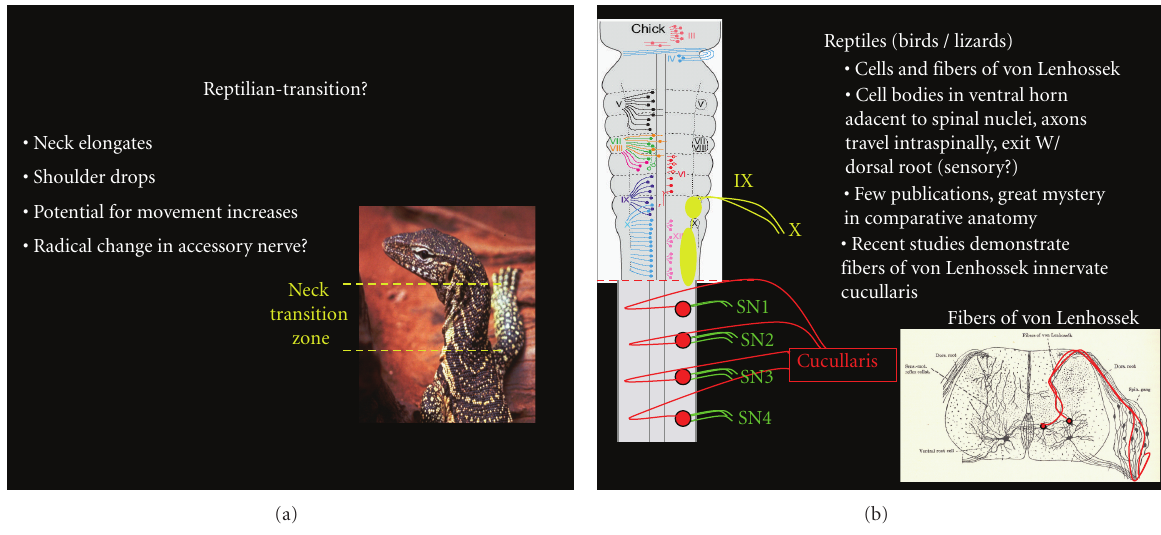
Figure 8: (a) The reptilian body undergoes distinct morphological changes including elongation of the neck and dropping of the shoulder girdles creating the neck transition region. (b) The formation of the neck region may explain the peculiar behavior of the fibers of von Lenhossek, which represent the reptilian spinal accessory nerve. More investigation is necessary to confidently provide a definitive explanation. Cell bodies of the accessory nerve in reptiles are located within the ventral horn of the cervical spinal cord. The axons project intraspinally to exit via the dorsal root. These fibers originally described by von Lenhossek remain poorly